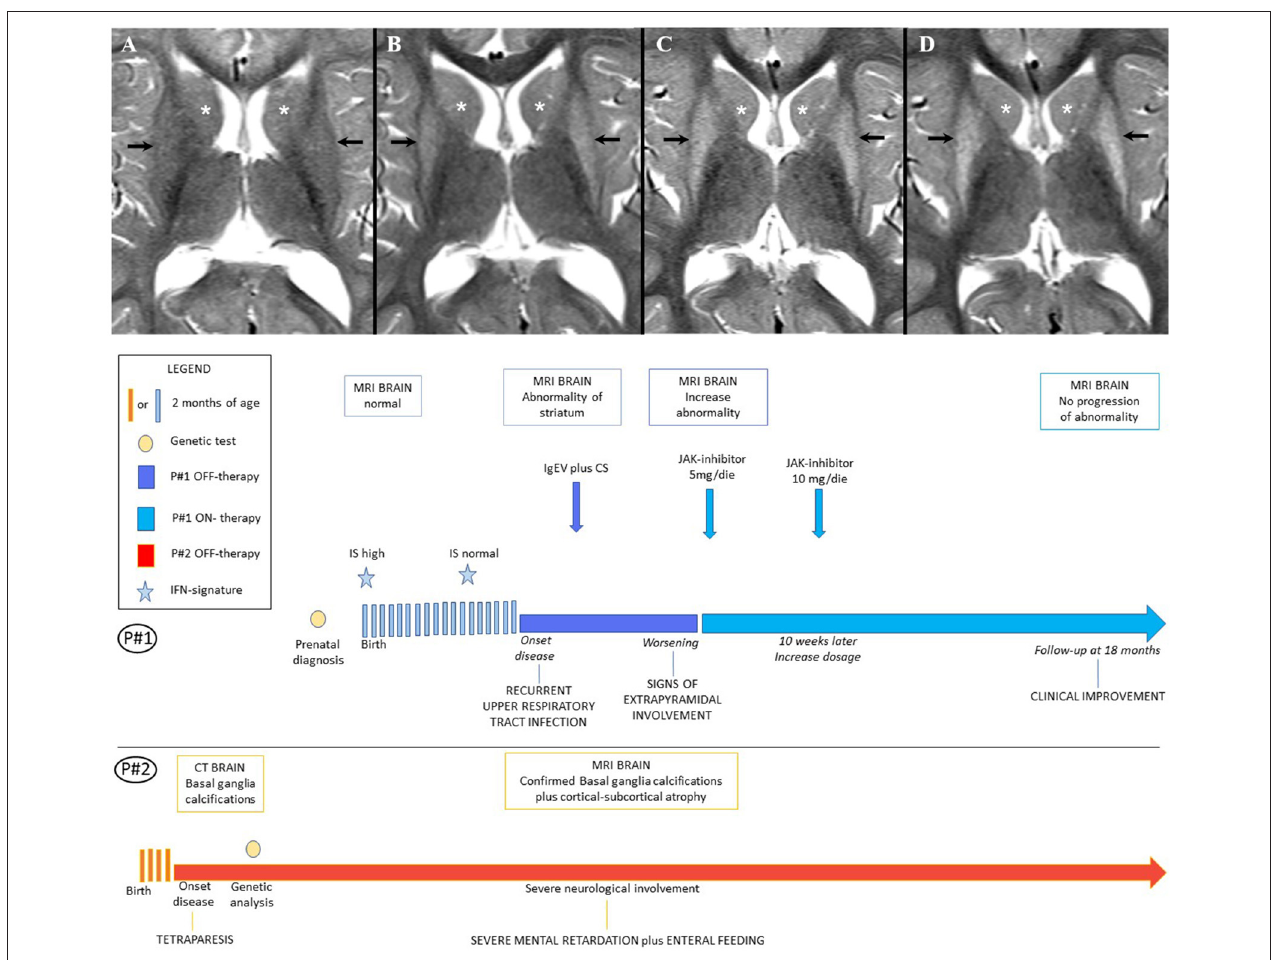
FIGURE 1 | (A) Patients’ Timeline. (B) Brain MRI. Brain MRI, axial T2-weighted image at the age of 18 months (A) , 36 months (B) , 40 months (C) , 5 years (D) . Putamen (black arrow) and head of caudate nucleus (white asterisk), show normal signal at 18 months (A) ; follow-up MRIs (B,C) show progressively increasing diffuse hyperintensity in both gray matter nuclei with volume loss of the putamina, consistent with bilateral striatal necrosis; after 18 months of therapy with Ruxolitinib the MRI (D) showed no progression of the basal ganglia